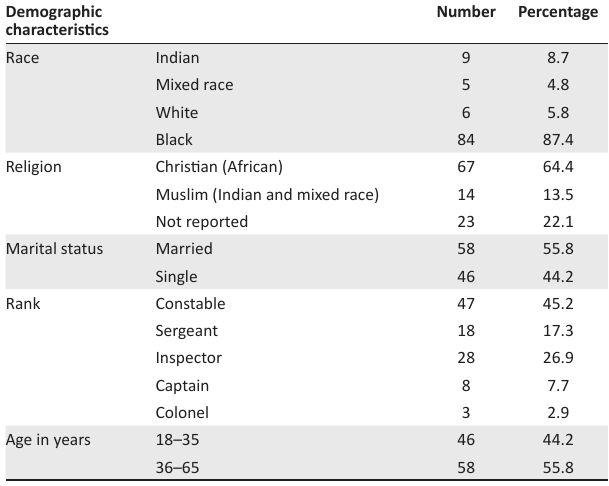
TABLE 1: Demographic characteristics of respondents ( N =